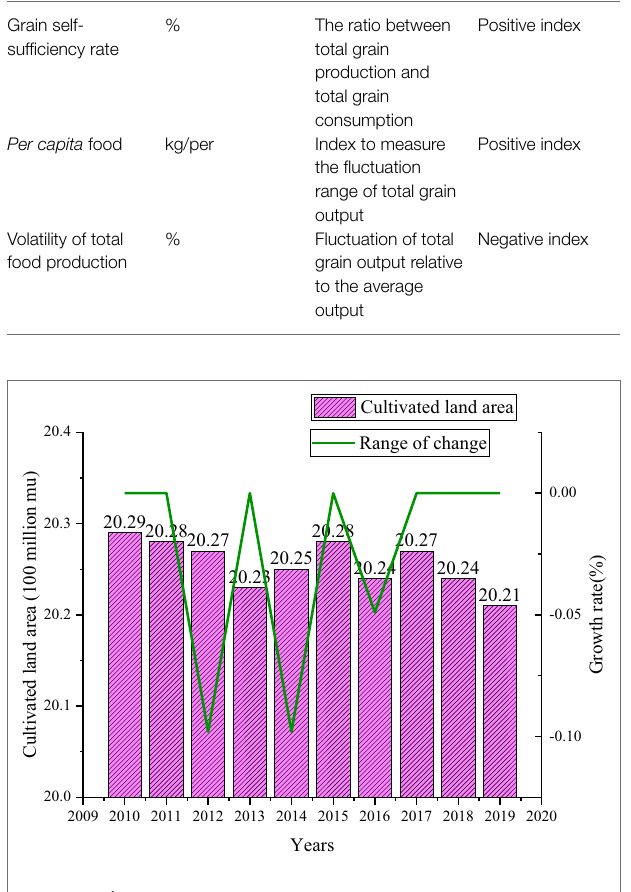
FIGURE 4 | The area of arable land from 2010 to